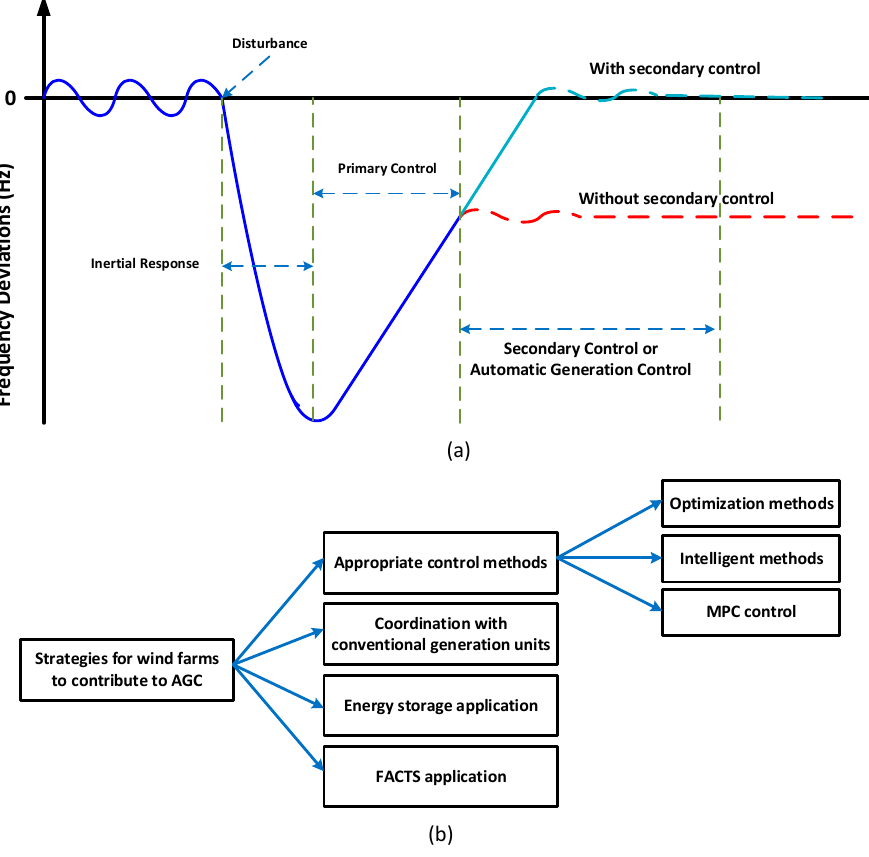
Figure 1. ( a ) Frequency regulation process; ( b ) control strategies for wind farms to contribute to the AGC. AGC, automatic generation control; FACTS, flexible AC transmission systems; MPC, model predictive control.